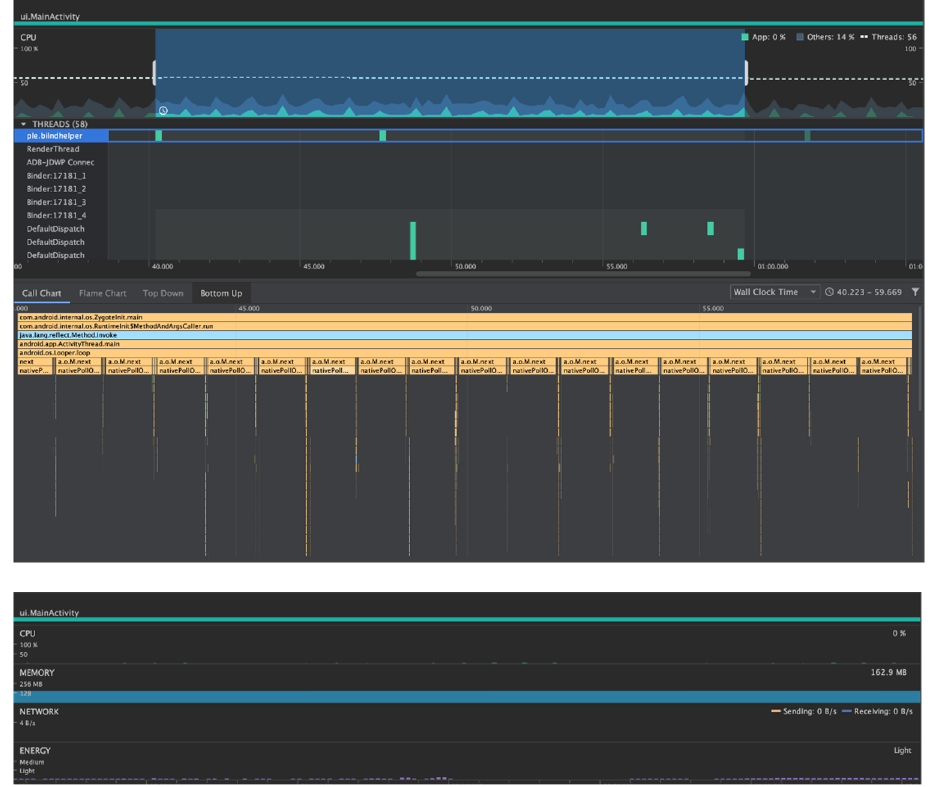
Figure 15. Median-36 filter CPU, memory and power load.